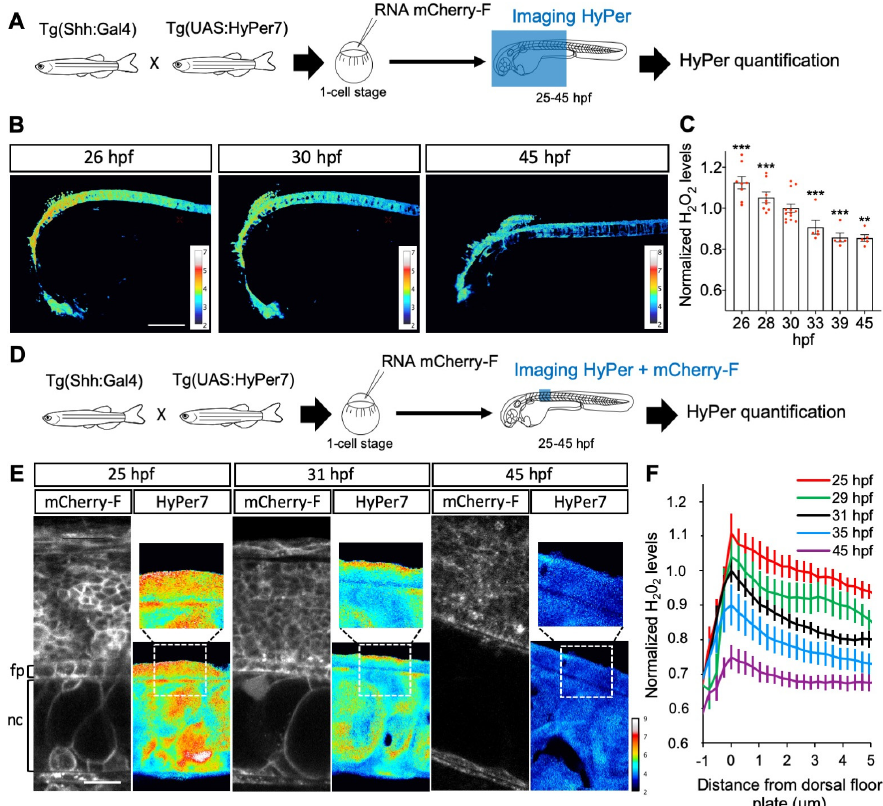
Figure 4. H 2 O 2 levels are dynamic in time and space in the floor plate. ( A , D ) Experimental procedures for the results shown in B–C ( A ) and E–F ( B ). ( B , C ) Variation in time. ( B ) H 2 O 2 levels in Tg(2.4Shha-ABC:Gal4-FF; UAS:Hyper7) zebrafish transgenic embryos at different times after fertilization as indicated (lateral view, anterior to the left). Scale bar, 200 μ m. ( C ) Variations in H 2 O 2 levels at different stages. Statistics are presented compared to 30 hpf. ( E , F ) Transient dorso-ventral gradient. ( E ) Embryos injected at the one-cell stage with mRNA for farnesylated mCherry (mCherry-F) were imaged for membranes (left panels: mCherry-F) and H 2 O 2 (right panels: HyPer7; bottom: same field as in the left panel; top: enlarged view as indicated by the dotted line). fp: floor plate; nc: notochord. Scale bar: 20 μ m. ( F ) Variations in H 2 O 2 levels along the apico-basal axis of MFP cells. ** p -value ≤ 0.01 and *** p -value ≤ 0.001. Details on statistics in Methods.